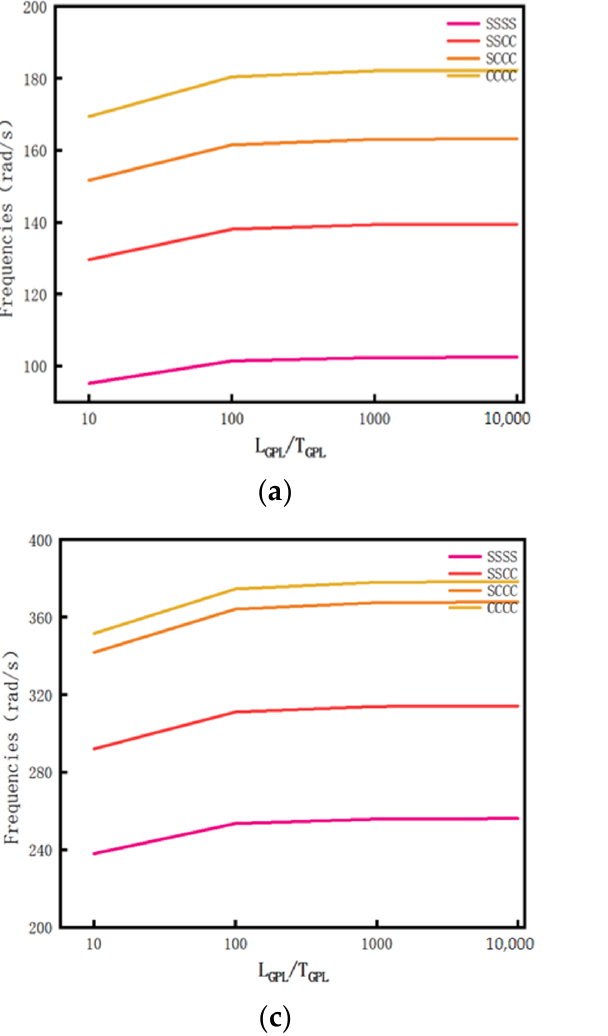
Figure 8. The relationship curve between L GPL / T GPL fraction and vibration frequency. ( a ) First order vibration mode, ( b ) second order vibration mode, ( c ) third order vibration mode, and ( d ) fourth order vibration mode.